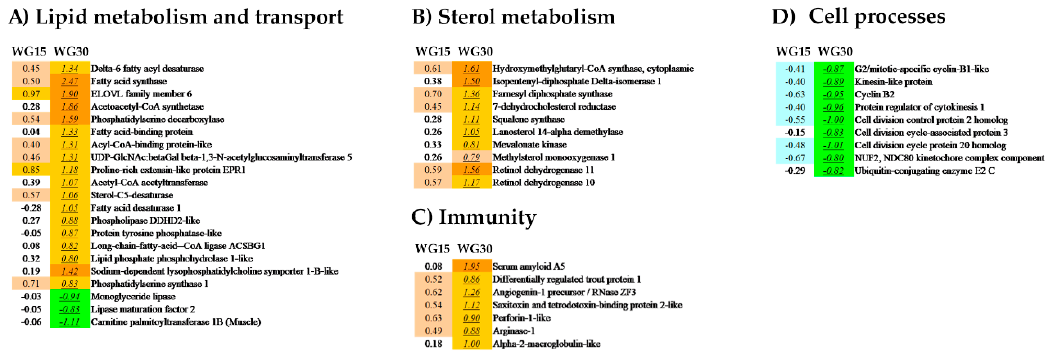
Figure 3. Major differentially expressed genes (DEGs) in the liver of salmon fed with WG containing diets; genes are related to ( A ) lipid metabolism, ( B ) sterol metabolism, ( C ) immunity, ( D ) cell processes. Data are folds to the FM-fed control group, DEGs ( > 1.754-fold, p < 0.05) are indicated with underlined italics.